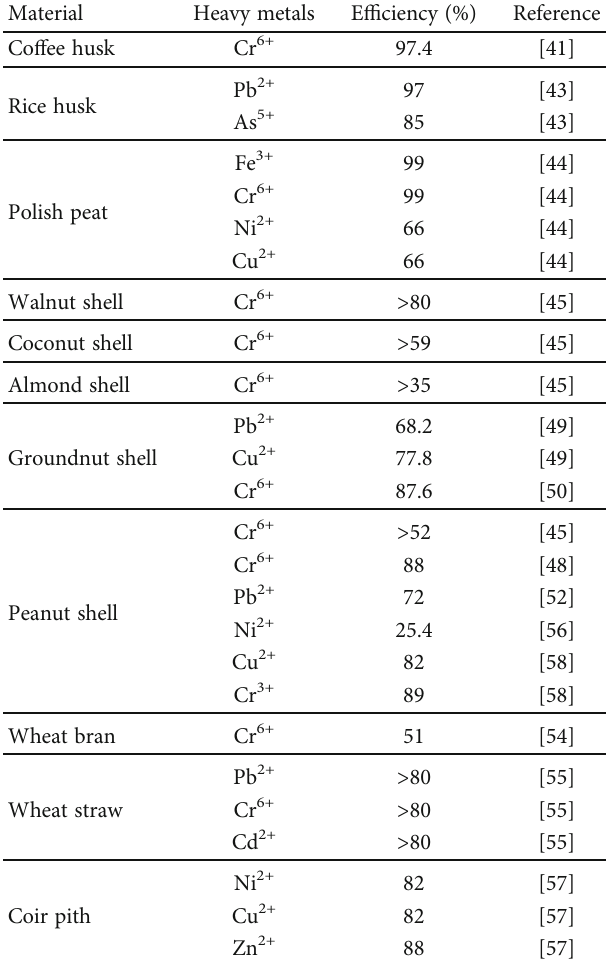
Table 4: Reported removal e ffi ciencies (%) of various biomass- derived adsorbents for the removal of di ff erent heavy